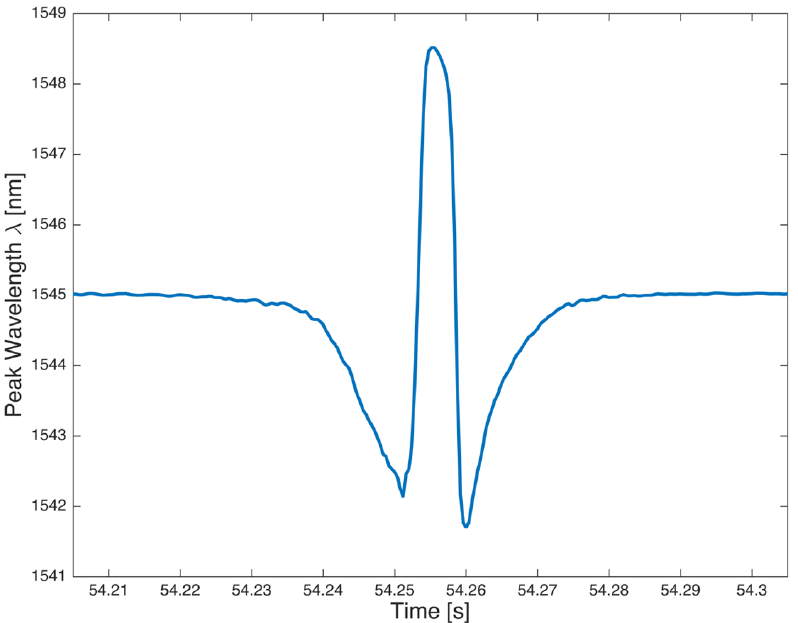
Figure 17. Reflected wavelength for a complete wheel turn.